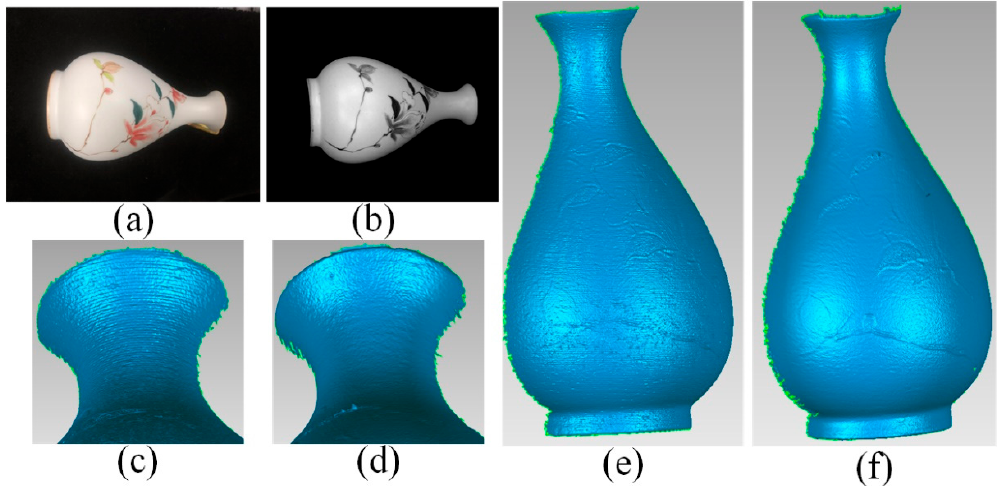
Figure 10. Results and comparisons of a vase. ( a ) A vase with colored texture and glossy reflection; ( b ) The visual albedo map; ( c ) Local areas by [42] are enlarged; ( d ) Local areas by ours are enlarged; ( e ) The reconstruction results by [42]; ( f ) The reconstruction results by ours.